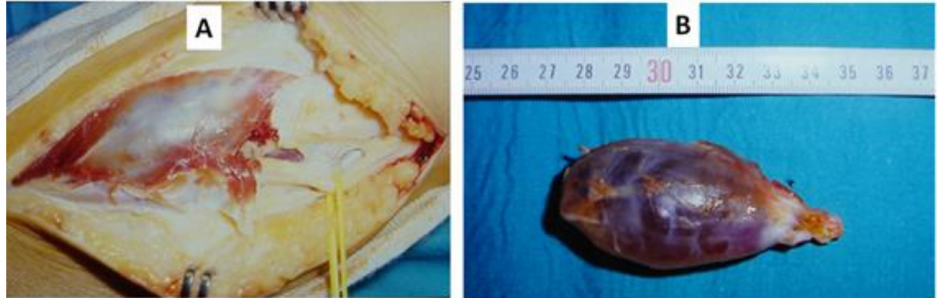
Figure 2. ( A ) Intraoperative image of upper tibio-peroneal cyst compressing the EPSN. ( B ) Sample of the superior tibio-peroneal cyst compressing the EPSN.